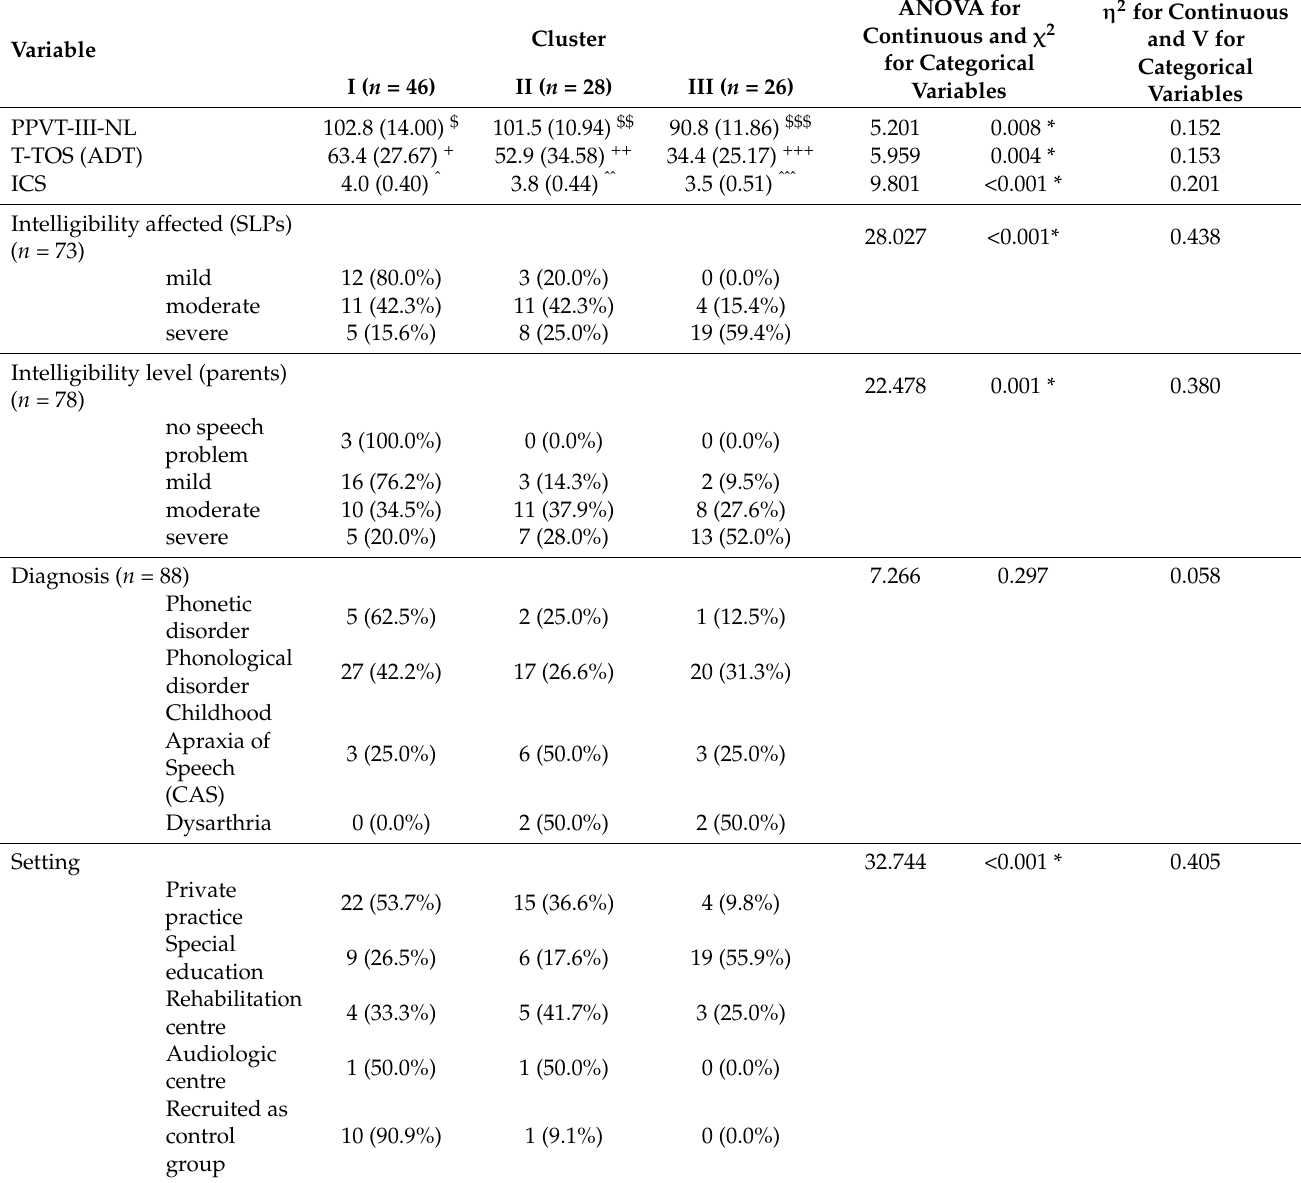
Table 5. Measures PPVT-III-NL, TTOS-ADT, ICS, intelligibility level SLP and parents, diagnosis and setting in three subgroups of children with SSD identified by cluster analysis ( n =